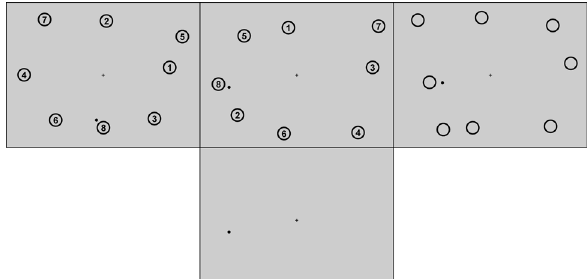
(top) of Experiments 1 (left), 2 and 3 (middle), and 4 (right) and in the blank-screen phase of all experiments